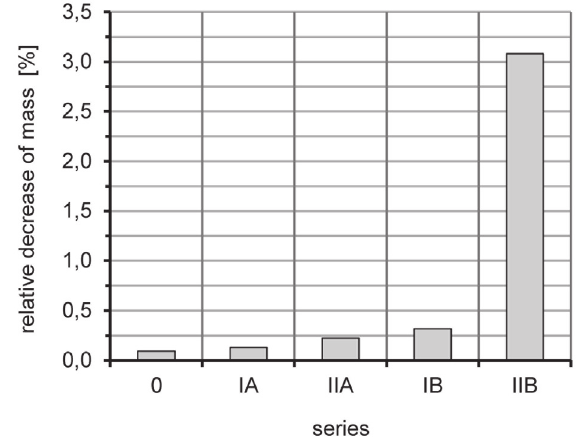
Figure 7: Relative mass